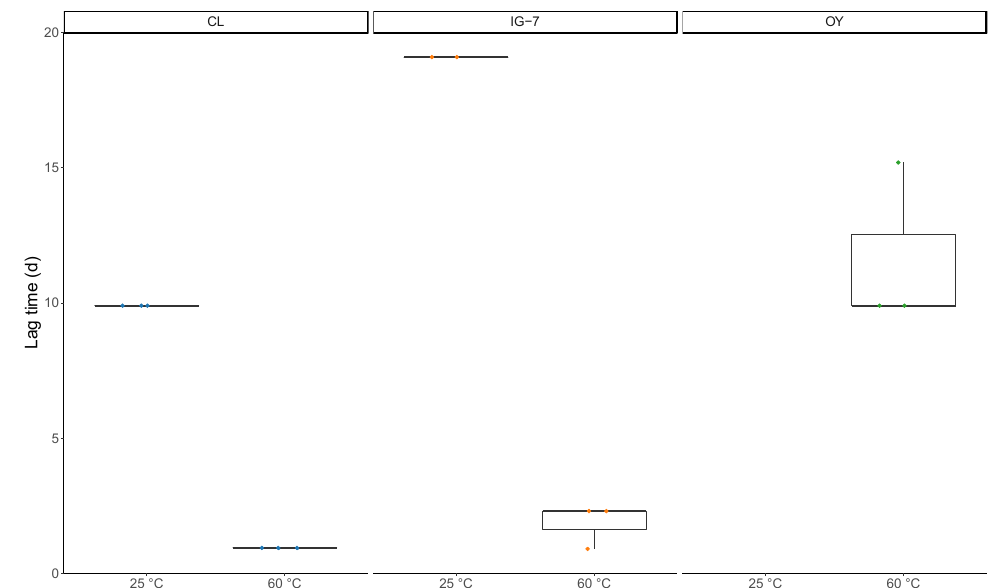
Figure 2. Box and whisker plot representation of apparent lag times (d) for each temperature (25 °C and 60 °C) at each site (CL, IG-7, and OY). Lag times are from CO uptake assay (Trial 1) with 25% CO. Median values are indicated by solid bars. Data not present (OY 25 °C) indicate no CO up-